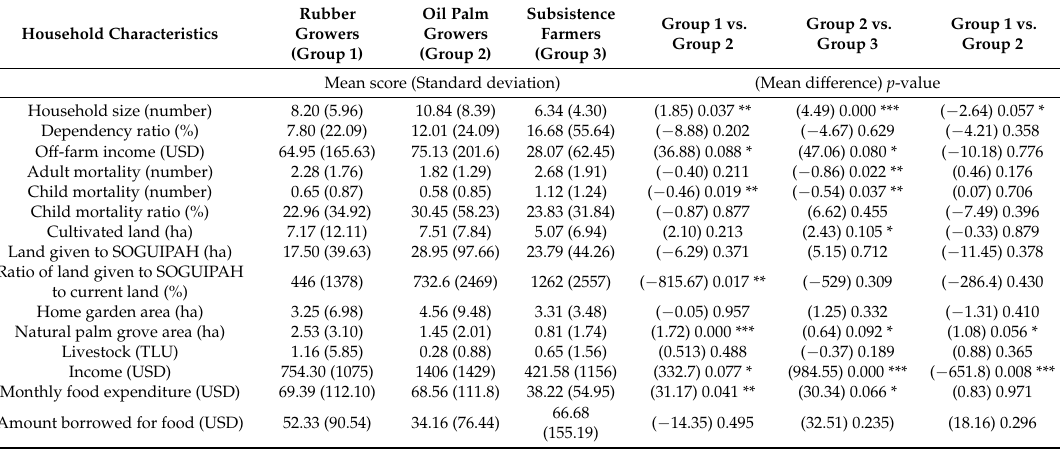
Table 2. Key household characteristics and differences between the study